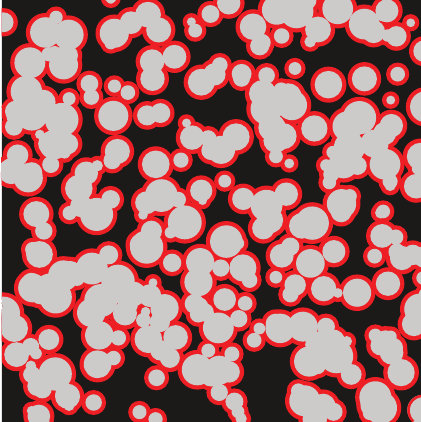
Figure 8: Planar intersection of a Boolean interphase model, pores- light gray, bulk phase-black, and interphase